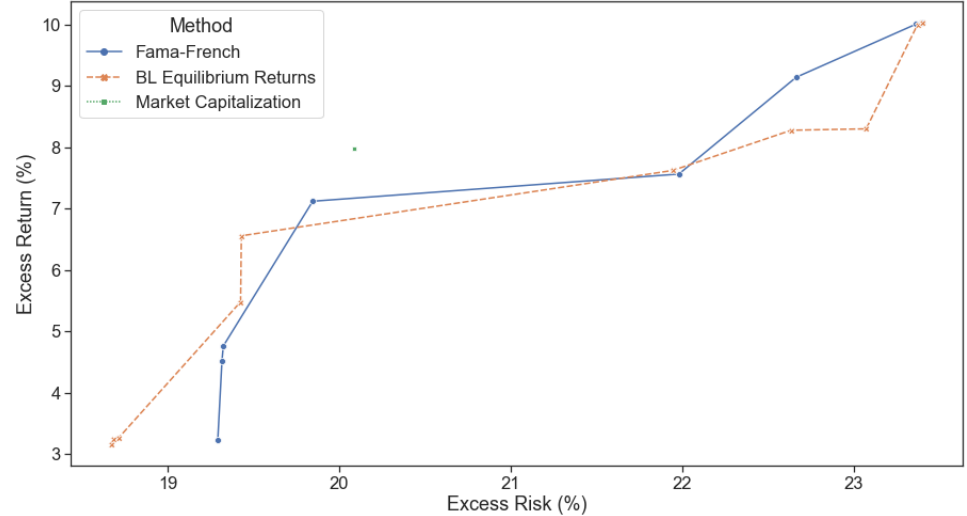
Figure 6. Single-period optimization (SPO) Efficient